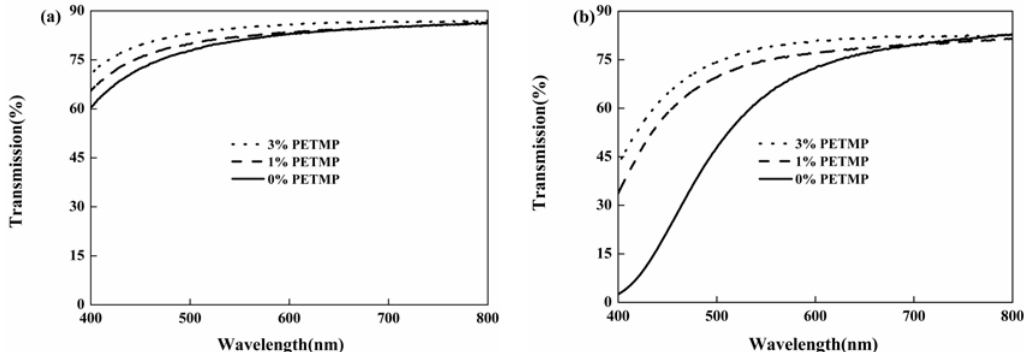
Figure 5. Effect of PETMP on the yellowing resistance of UV-cured polyurethane coatings: the UV-cured coatings ( a ) and the UV-cured coatings which were treated at 120 °C for 4 h ( b ).